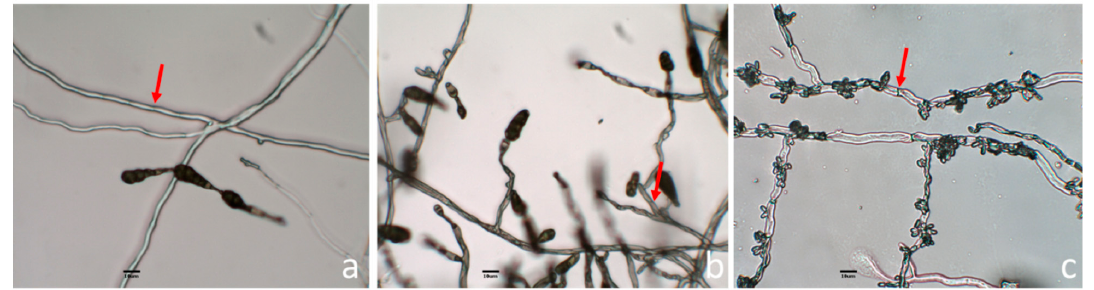
Figure 4. Morphological examination of microscopic aerial structures from Ac1 ( a ), Lc1 ( b ) and, Ec1 ( c ). The aerial structures of the three fungi were observed with the 40× objective. The septa are indicated by a red arrow.